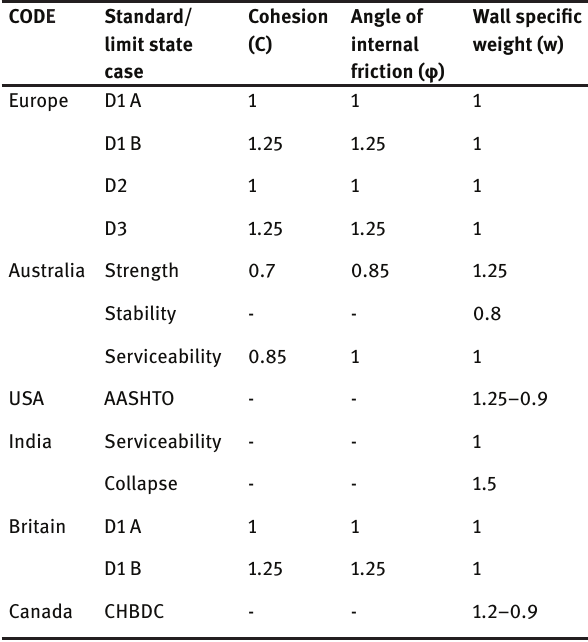
Table 2: Partial factors of safety applied on material